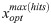
Replicating previous work using the best-fit parameters found in Experiment 1.A) We simulated the experiment of Izawa and Shadmehr (2011) using our learning model. Reach angle (y-axis) over trials (x-axis) as simulated by our model is shown in green (n = 18). The inset display the original behavioural data (black line) reported from Izawa and Shadmehr (2011; reprinted with permission). Our model captures both the linear change in reach angle and the between-subject variability. B) We then simulated a previous experiment of ours [5]. Hand position (i.e., compensation, mm) over trials (x-axis) as simulated by our model is shown in green (n = 30). The inset shows the original behavioural data, where the dark red line represents the hand position of participants when they are receiving only binary reinforcement feedback to perform the task ([5]; reprinted with permission). xoptmax(hits) represents the optimal location to aim the hand to maximize target hits (reward). Here, the model replicates the exponential learning curve, between-subject variability and suboptimal performance.